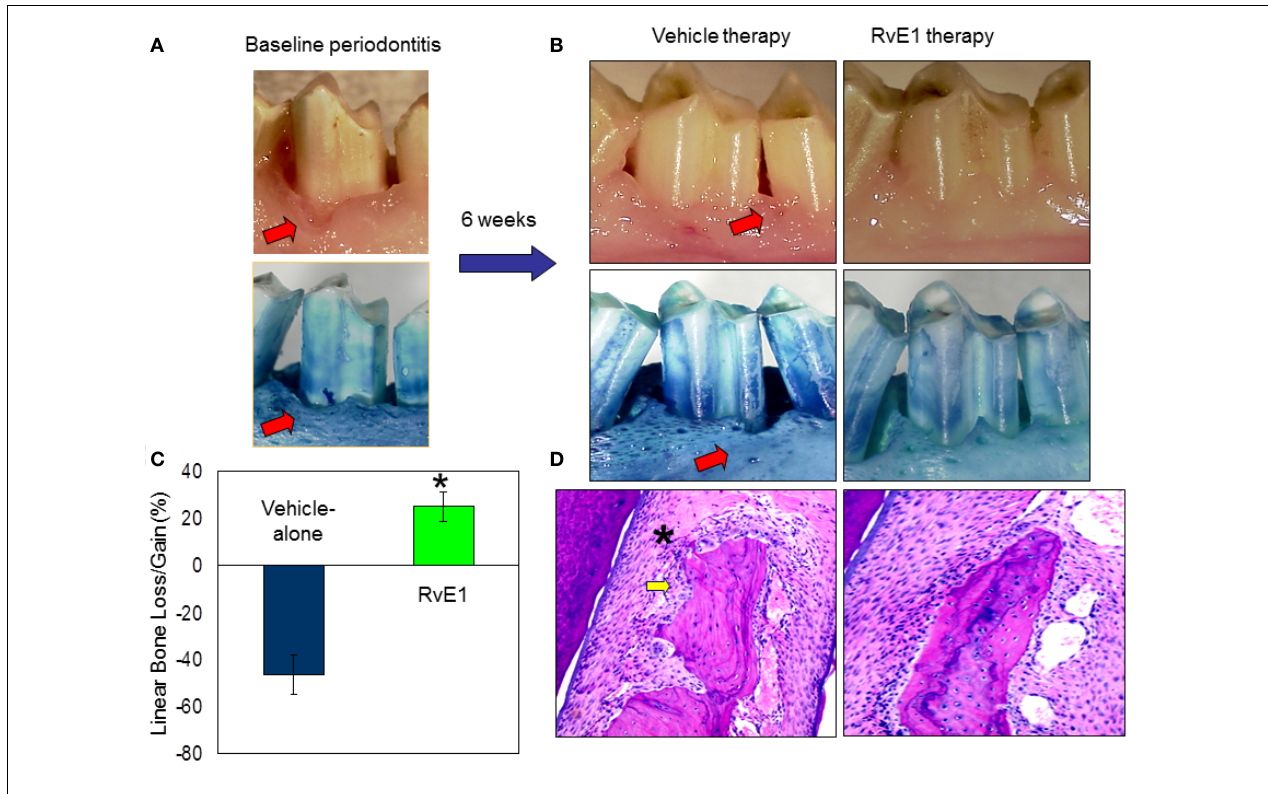
state.Vehicle treatment did not have any impact on controlling the disease, conversely the disease continued to progress. (C) Histological evaluations confirmed the clinical observations where RvE1 treated sites showed no bone loss and no or minimal inflammatory cell activity. (D) Histomorphometric evaluations quantified the bone level changes during these treatments over 6weeks.While RvE1 treatment resulted in